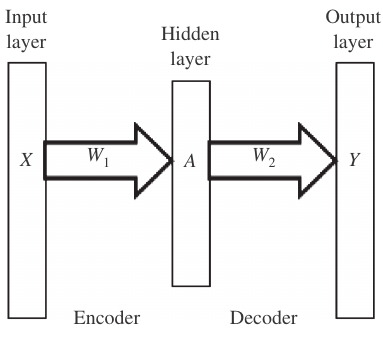
Figure 3: Auto-encoder